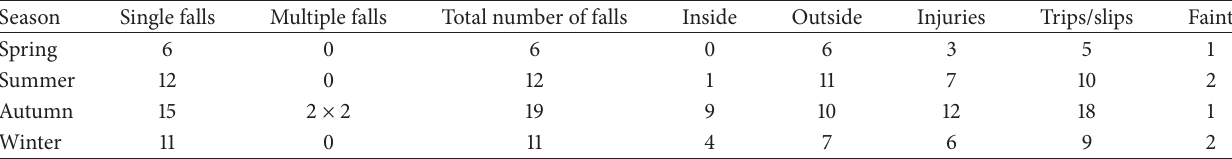
Table 2: Fall incidence, injury, location, and cause reported as grouped by